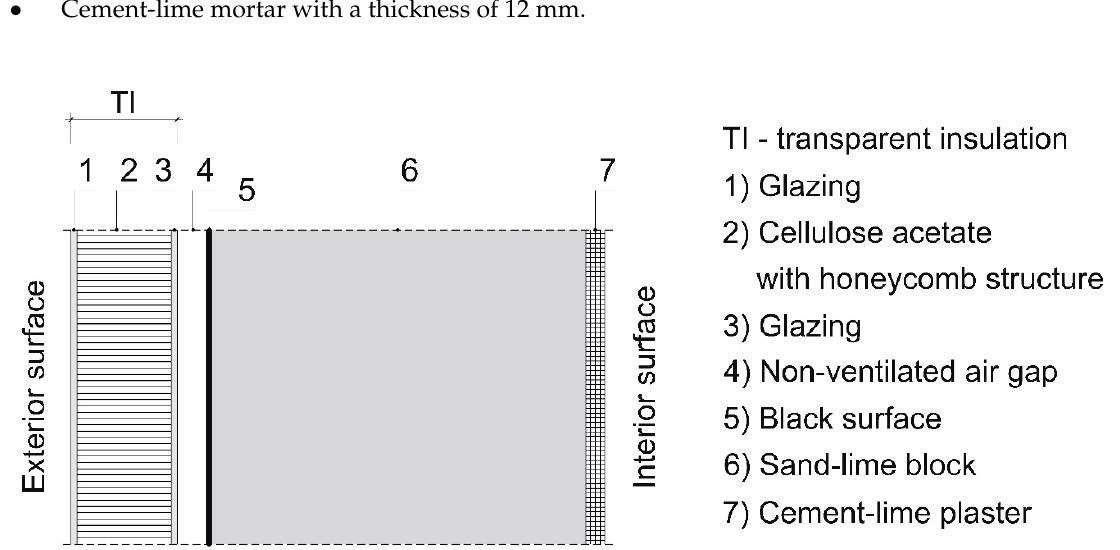
Figure 1. The analyzed solar wall with transparent insulation.